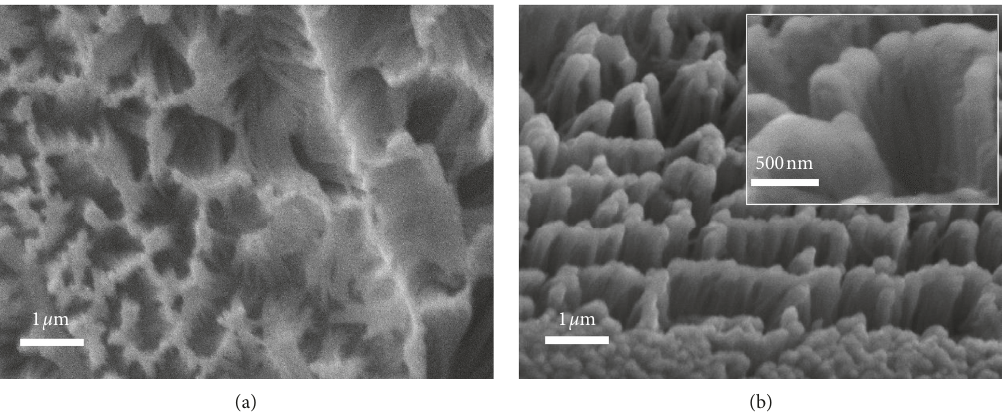
Figure 4: Top-view (a) and cross section (b) SEM images of Si nanowires arrays formed after the 15min HF-H substrate covered with AuNPs deposited from a solution of 4mM H[AuCl 4 ] at 50 ° C.